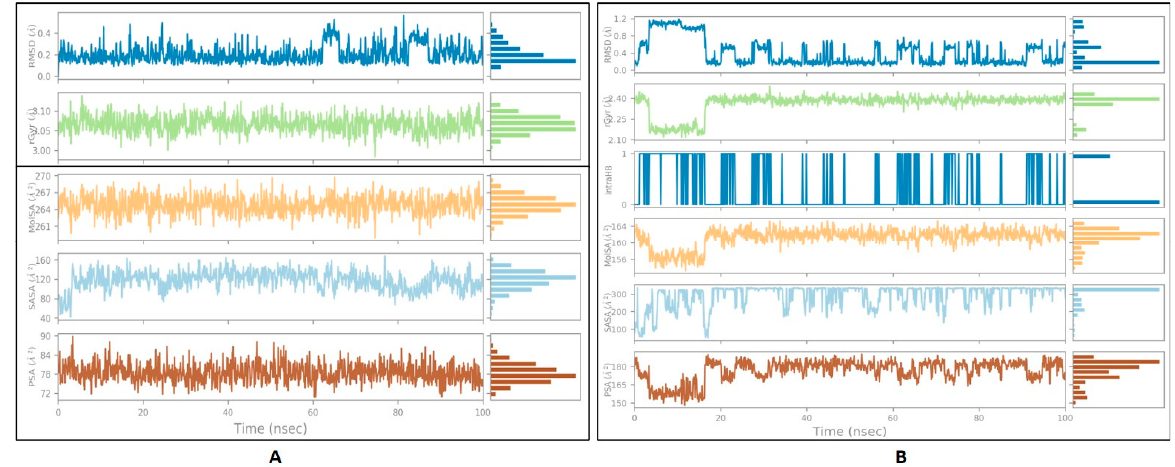
Figure 5. The properties of the ligands:( A ) michelalbine; ( B ) gentisic acid.